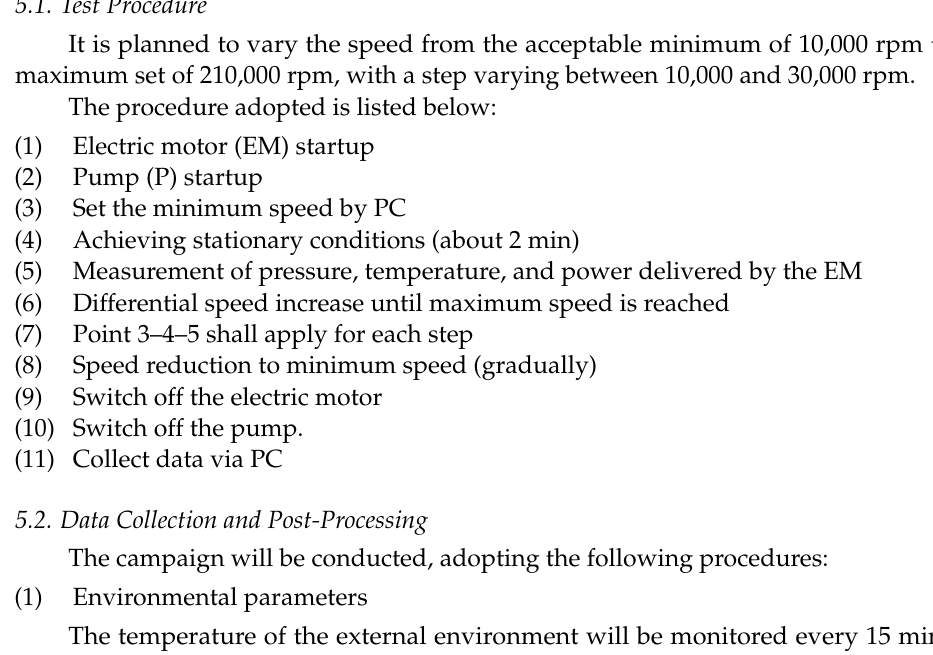
Figure 18. Test bench Concept.